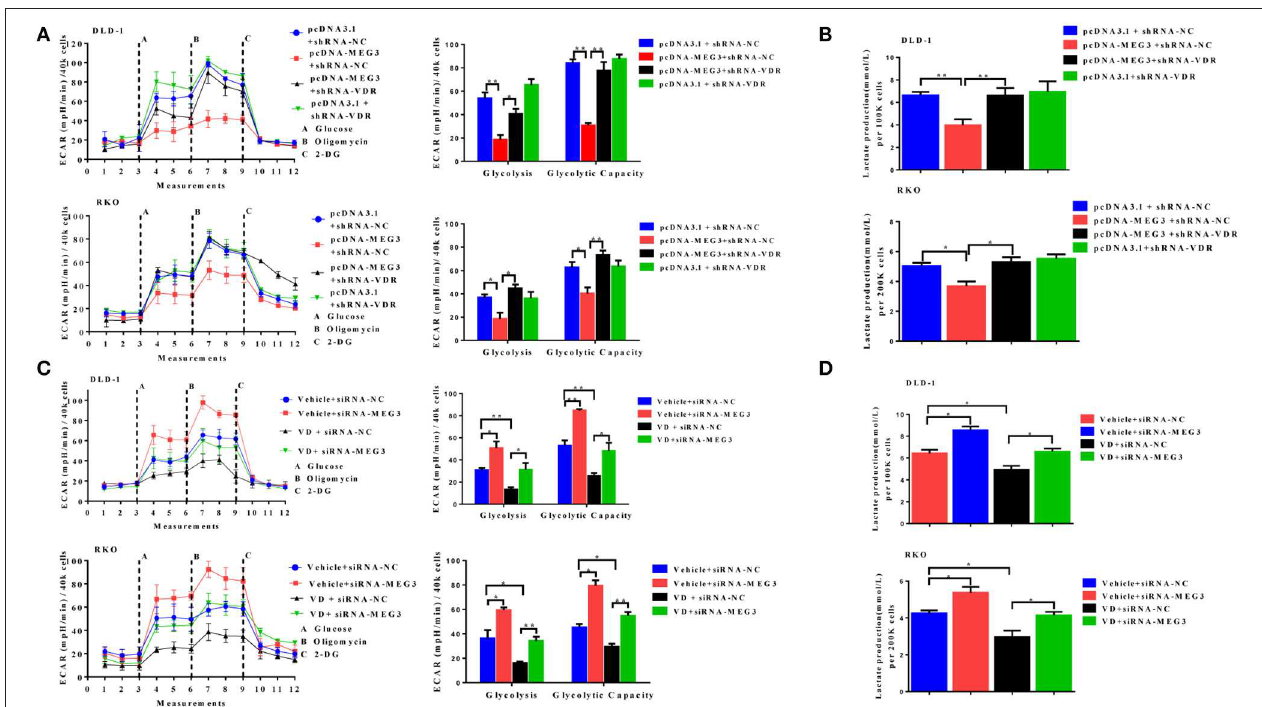
FIGURE 6 | Vitamin D receptor (VDR) knockdown abolishes the effect of maternally expressed gene 3 ( MEG3 ) on glucose metabolism. The extracellular acidification rate (ECAR) ( A , left panel) and lactate production (B) were measured in colorectal cancer (CRC) cell lines with MEG3 overexpression and weak VDR expression (pcDNA-MEG3 + shRNA-VDR) or with MEG3 overexpression and base VDR expression (pcDNA-MEG3 + shRNA-NC). CRC cells with low expression of MEG3 were treated with 1 α ,25(OH) 2 D 3 (vitamin D) (VD + siRNA-MEG3) or vehicle (Vehicle + siRNA-MEG3), and the ECAR ( C , left panel) and lactate production (D) were measured. Glycolysis and glycolytic capacity were analyzed using XF Glycolysis Stress Test software (right panels of A,C ). Data are expressed as mean ± standard deviation from three independent experiments. * P < 0.05, ** P <